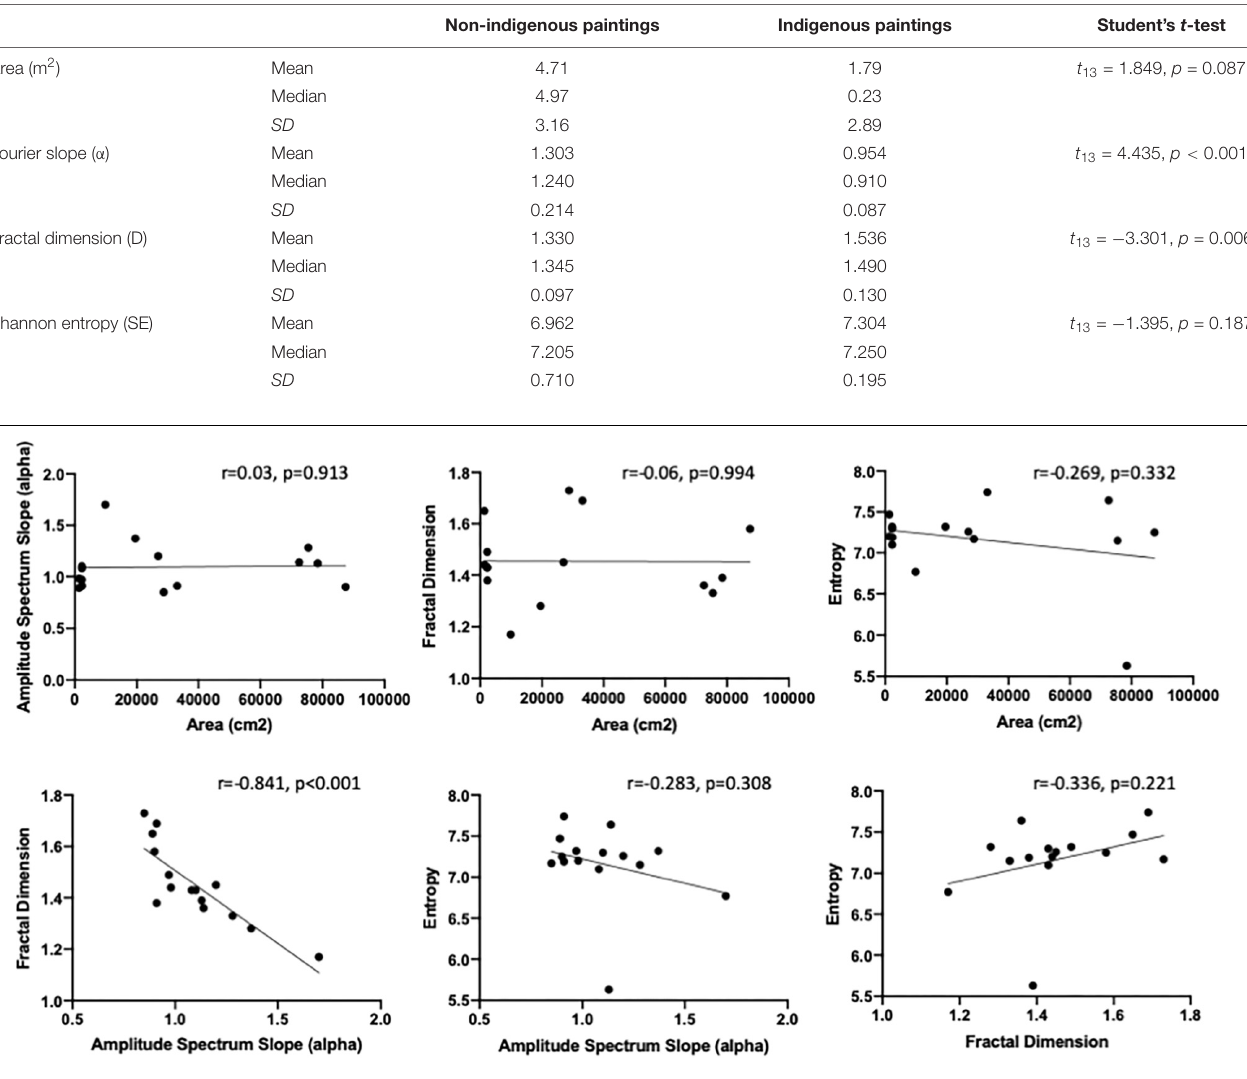
FIGURE 4 | Scatterplots between different image statistics for the 15 paintings used in this study: (top row) Painting area vs. Amplitude spectrum slope (left panel) , Fractal dimension (middle panel) and Shannon entropy (right panel) ; (bottom row) Amplitude spectrum slope vs. fractal dimension (left panel) , and Shannon entropy (middle panel) , Fractal dimension vs. Shannon entropy (right panel)